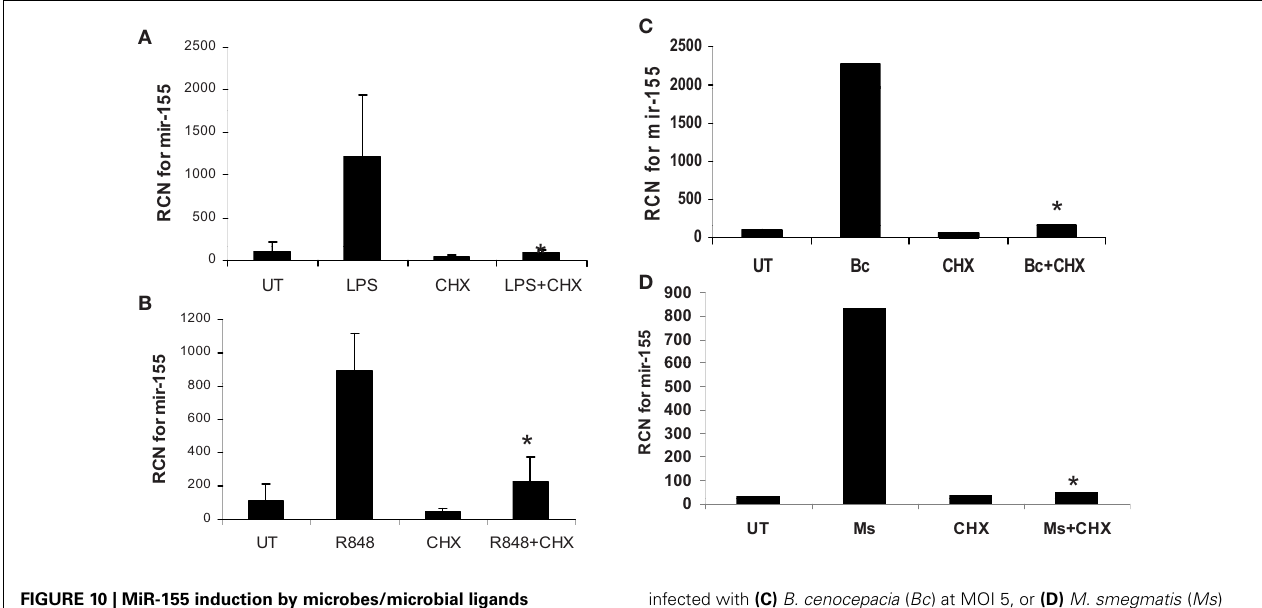
FIGURE 10 | MiR-155 induction by microbes/microbial ligands requires de novo protein synthesis. (A–D) Human PBM were pre-treated with or without the protein synthesis inhibitor (CHX), and subsequently treated with (A) LPS (500ng/ml), (B) R848 (1uM), or